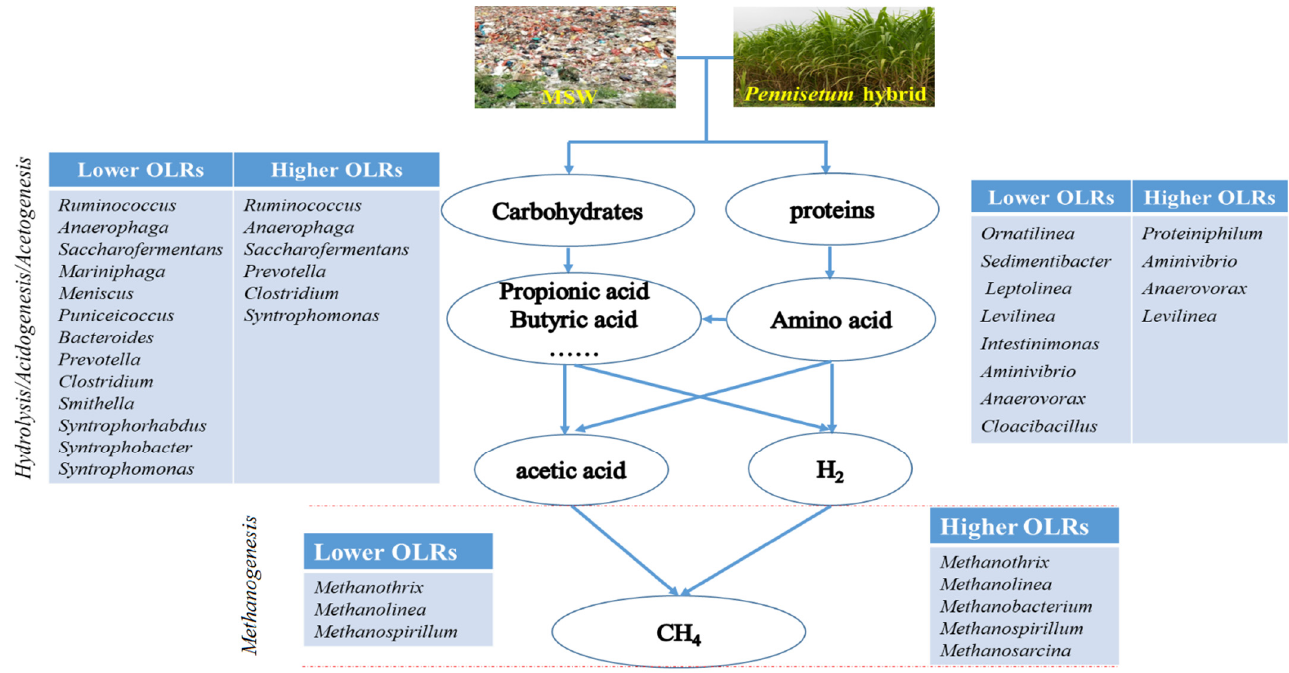
Figure 6. Shift of microorganism during the process of co-digestion system.